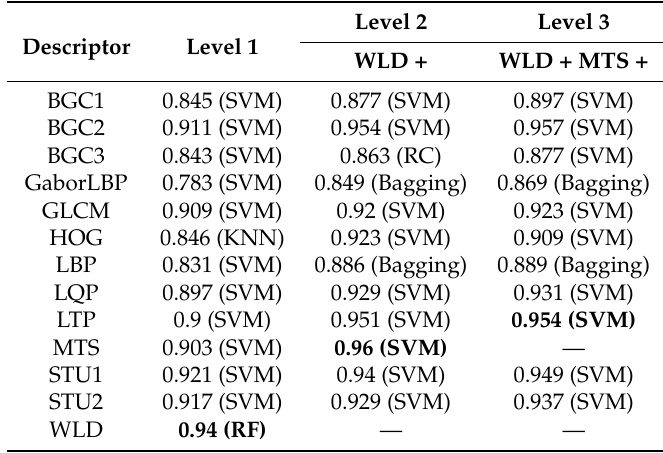
Table 3. Forward Subset Selection of descriptors applied to 8 × 8 gridded image (also known as FSS 8 ×